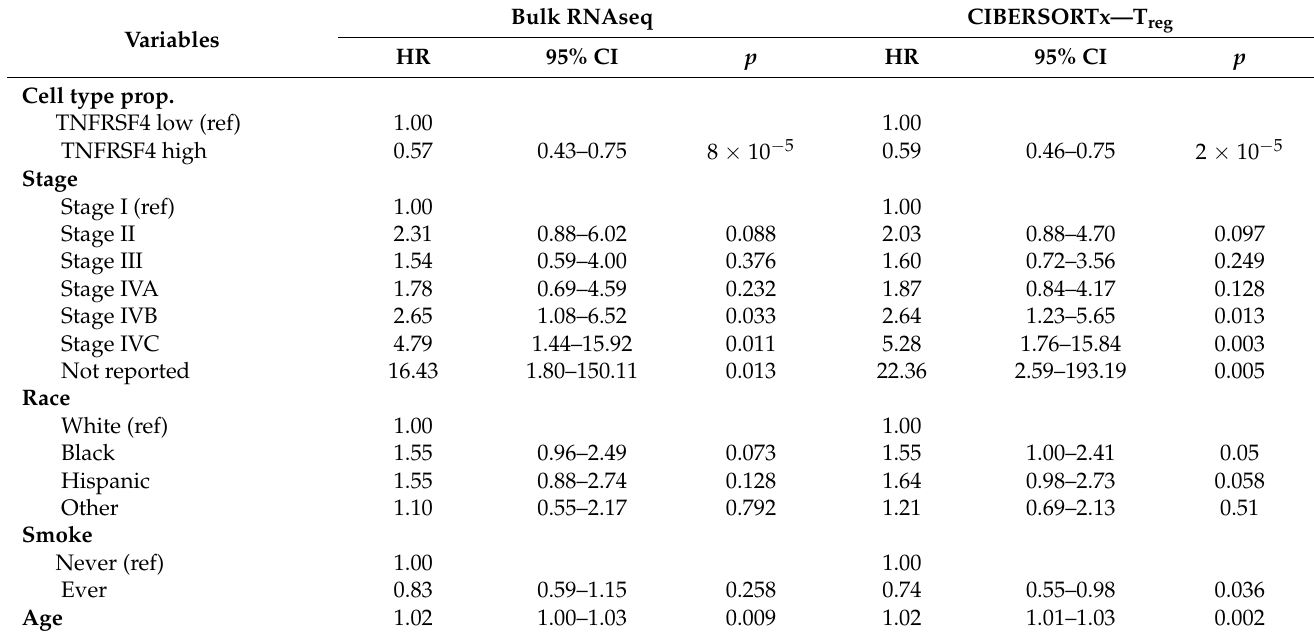
Table 4. Cox proportional-hazard regression analysis for survival and TNFRSF4 expression estimated by bulk RNA-seq and CIBERSORTx (prop., proportion; HR, hazard ratio; CI, confidence interval; ref, reference). Bulk Variables